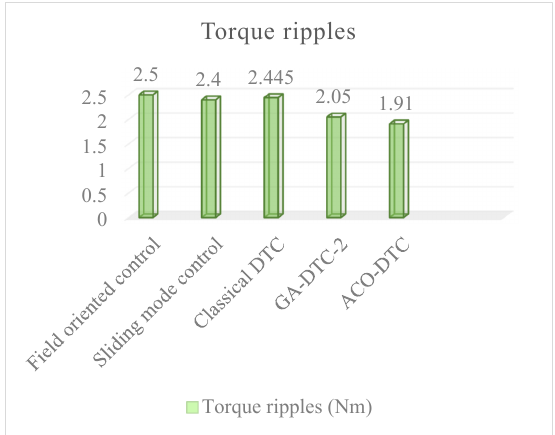
Figure 20. Various torque ripples of several approaches for DFIM.